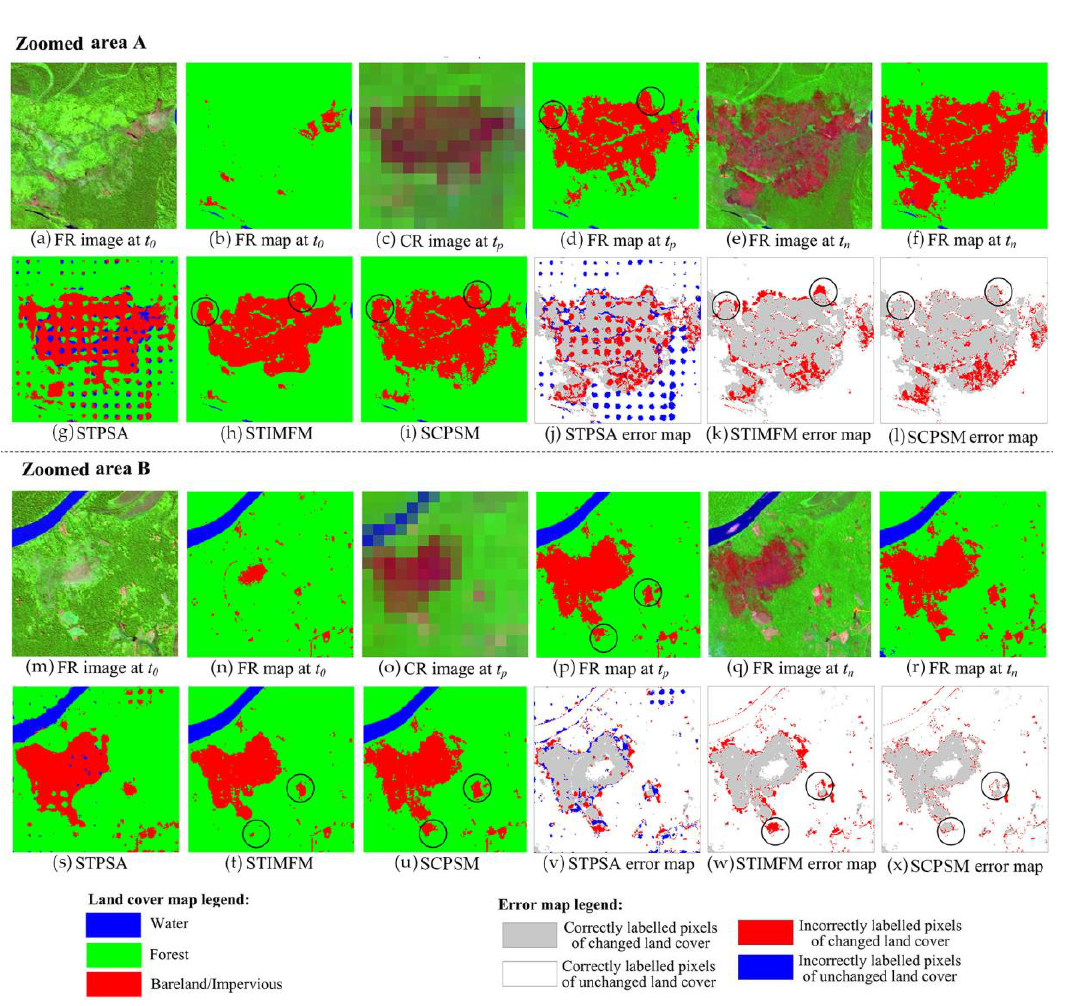
Figure 9. Input, reference, resulting land cover maps, and error maps for the zoomed areas in Figure 8 in the forest fire experiment. Each zoomed area contains 240 × 240 FR pixels. ( a )–( l ) are the input, reference, resulting maps and error maps for zoomed area A: ( a ) FR image at t 0 ; ( b ) FR map at t 0 ; ( c ) CR image at t p ; ( d ) FR map at t p ; ( e ) FR image at t n ; ( f ) FR map at t n ; ( g ) STPSA; ( h ) STIMFM; ( i ) SCPSM; ( j ) STPSA error map; ( k ) STIMFM error map; ( l ) SCPSM error map. ( m )–( x ) are the input, reference, resulting maps and error maps for zoomed area B: ( m ) FR image at t 0 ; ( n ) FR map at t 0 ; ( o ) CR image at t p ; ( p ) FR map at t p ; ( q ) FR image at t n ; ( r ) FR map at t n ; ( s ) STPSA; ( t ) STIMFM; ( u ) SCPSM; ( v ) STPSA error map; ( w ) STIMFM error map; ( x ) SCPSM error